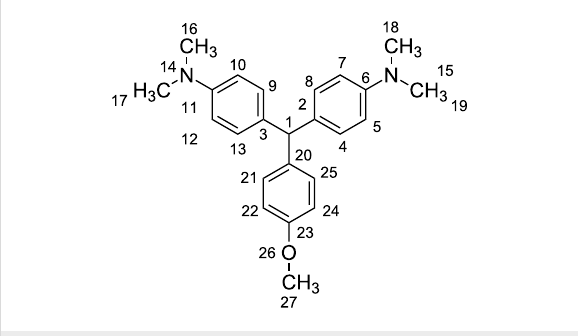
Figure 1: Molecular structure of compound 11 .